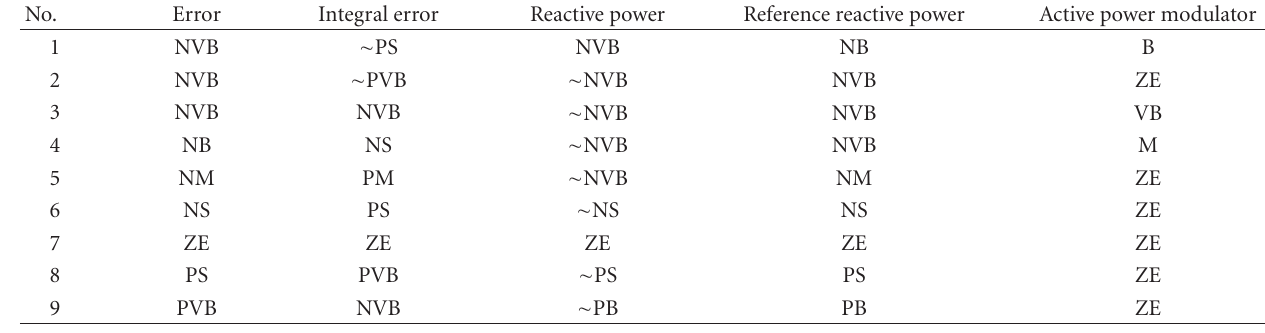
Table 1: Rules of fuzzy controller.